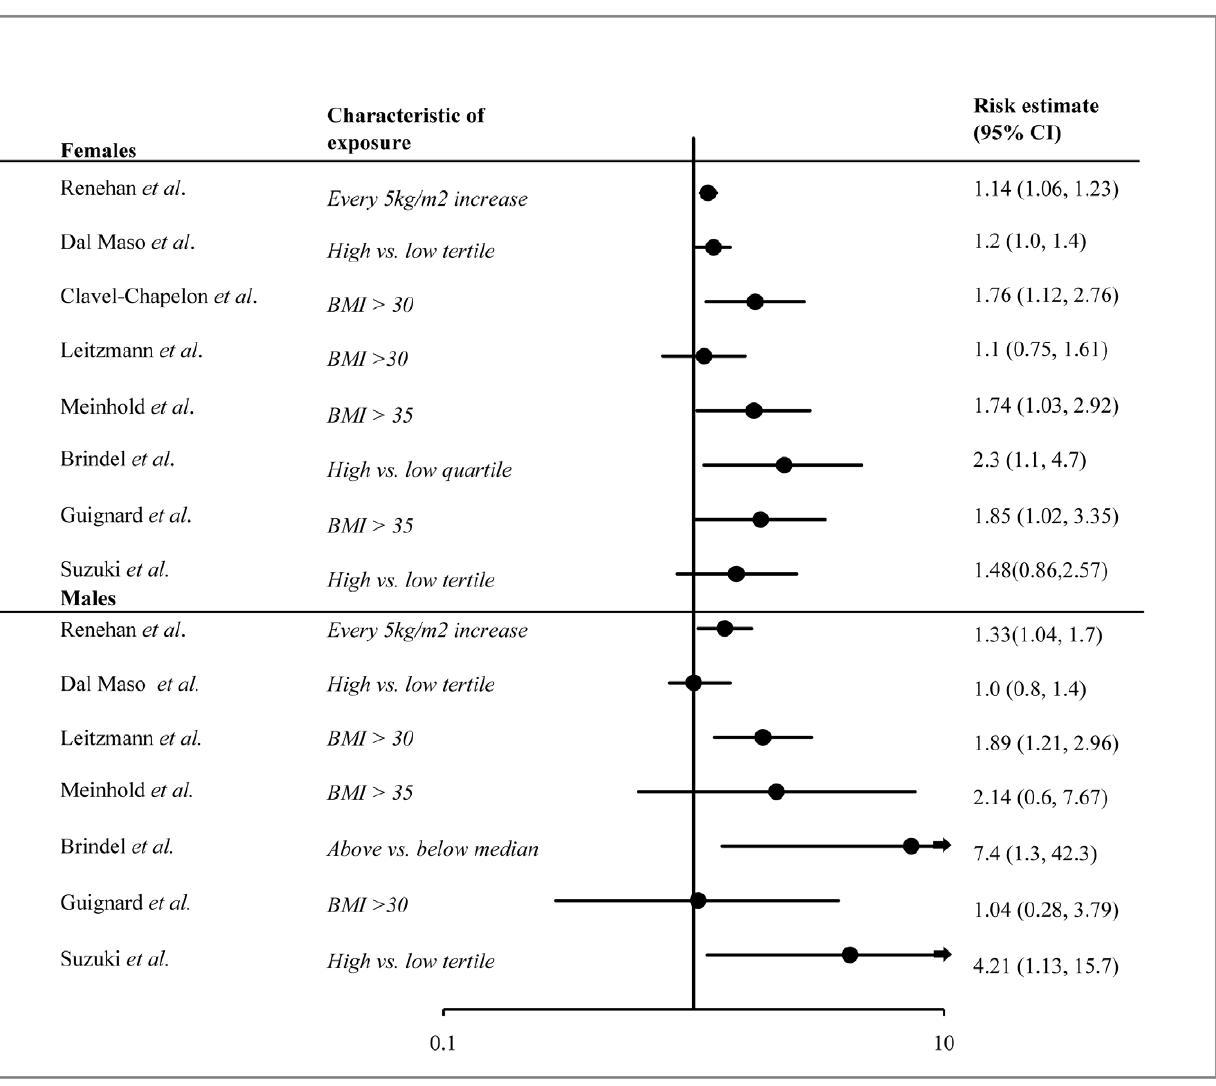
Figure 2. Forest plot of risk estimates for BMI and thyroid cancer for all pathologies of thyroid cancer and all age groups. A meta- analysis of the data was not performed due to the heterogeneity of the methods and risk factor definitions across studies. Notable differences in study characteristics and study samples are indicated on the plot.